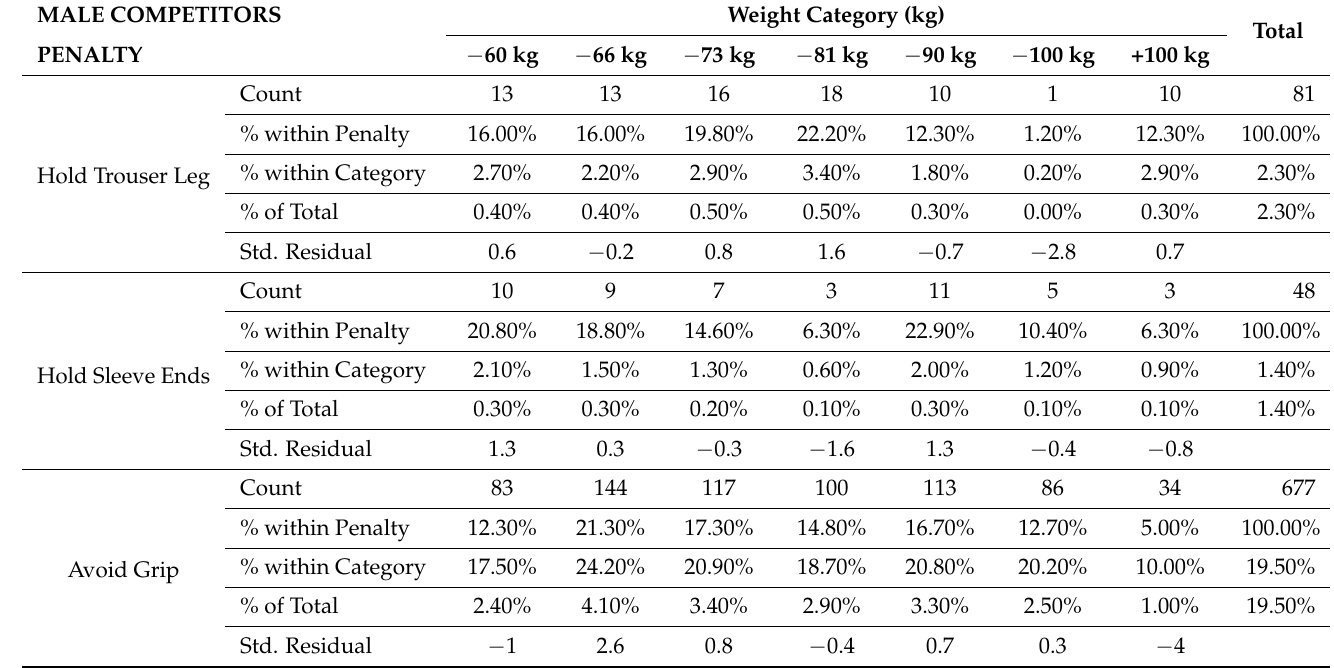
Table 2. Frequencies, percentage values and standardised residuals of individual penalties in all weight categories for male